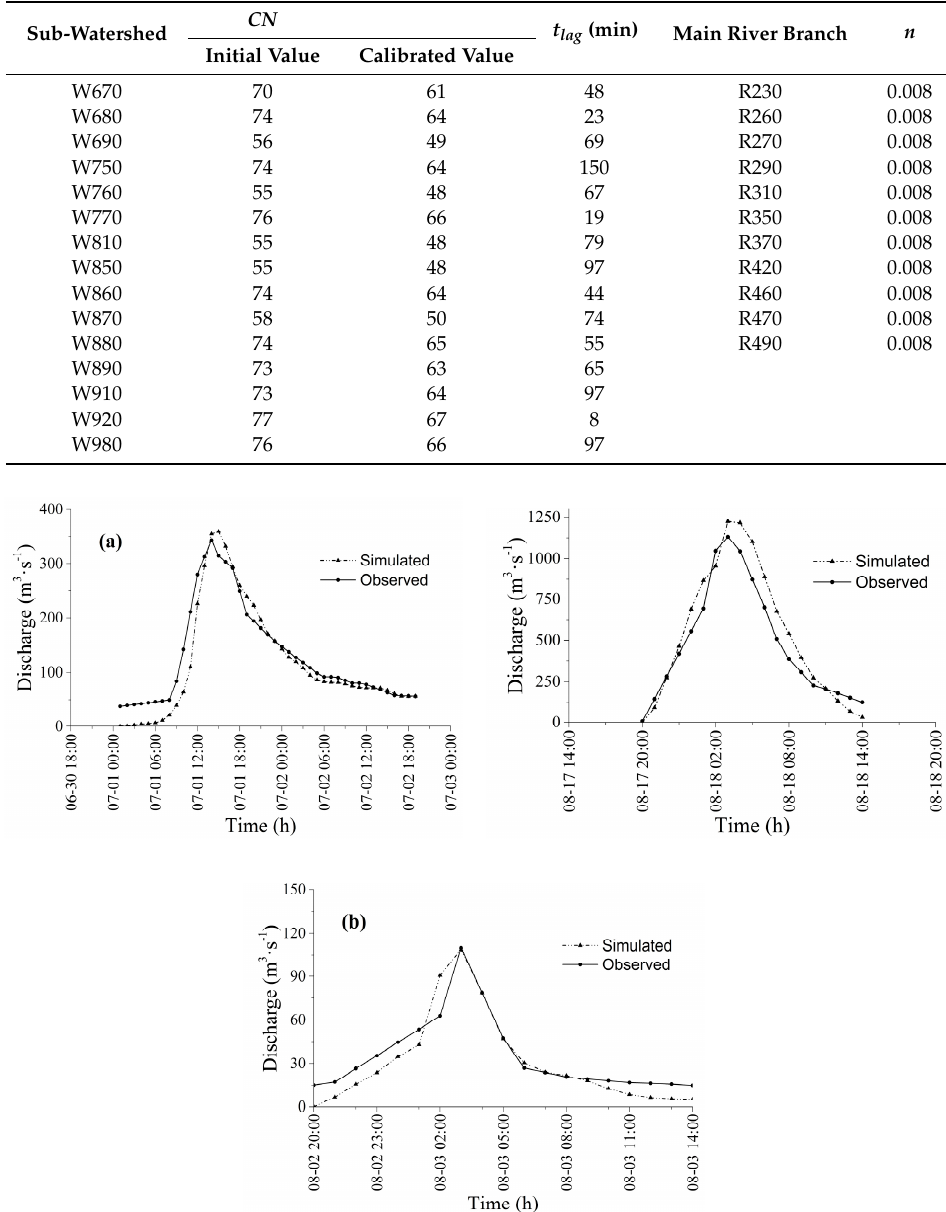
Table 6. Calibrated parameter values.